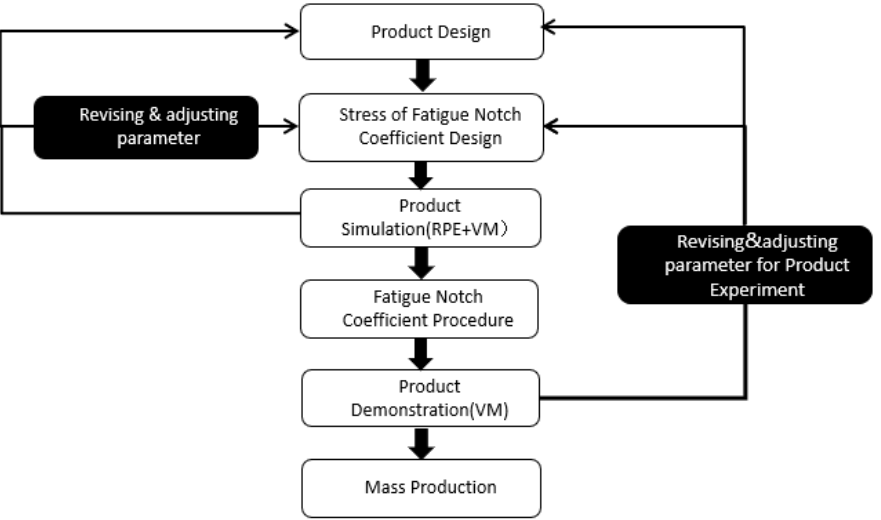
Figure 1. Flow chart using the recognizable performance of virtual measurement to ensure fatigue notch coefficient product quality.